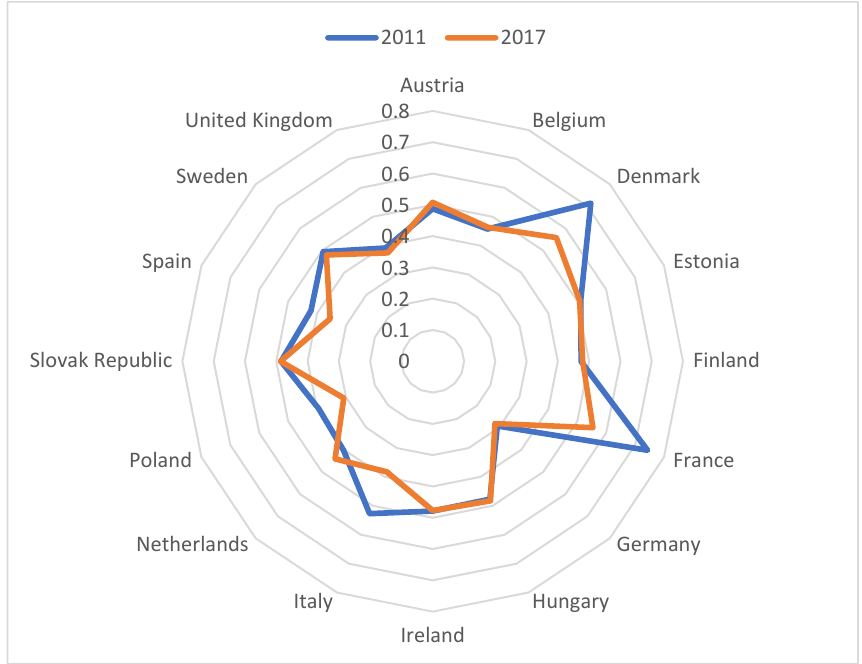
Figure 7. The average level of environmental performance of the hydrogen and fuel cell technologies R&D (million USD and PPP) for selected EU countries in 2011 and 2017.